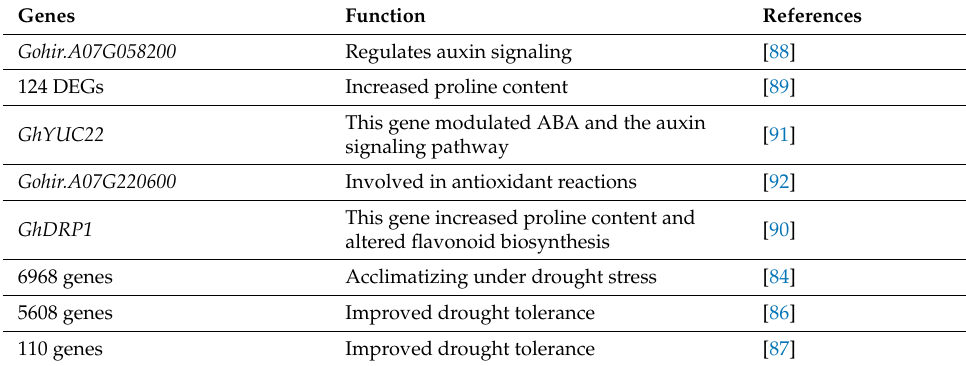
Table 4. List of different transcriptomes identified for drought tolerance in